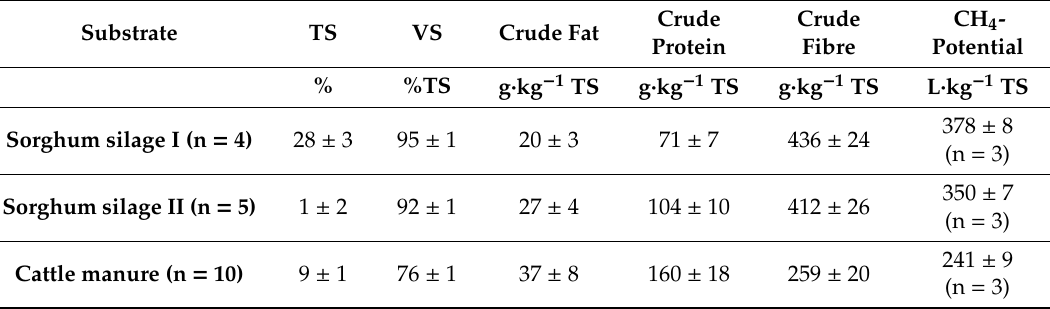
Table 1. Feedstock analyses of the substrates